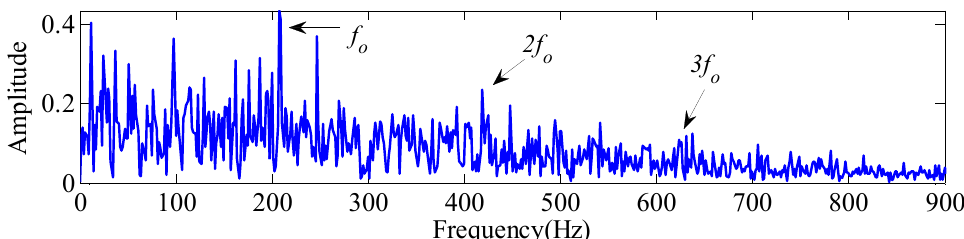
Figure 27. Noise reduction diagram of the signal segment selected by the algorithm in this paper.